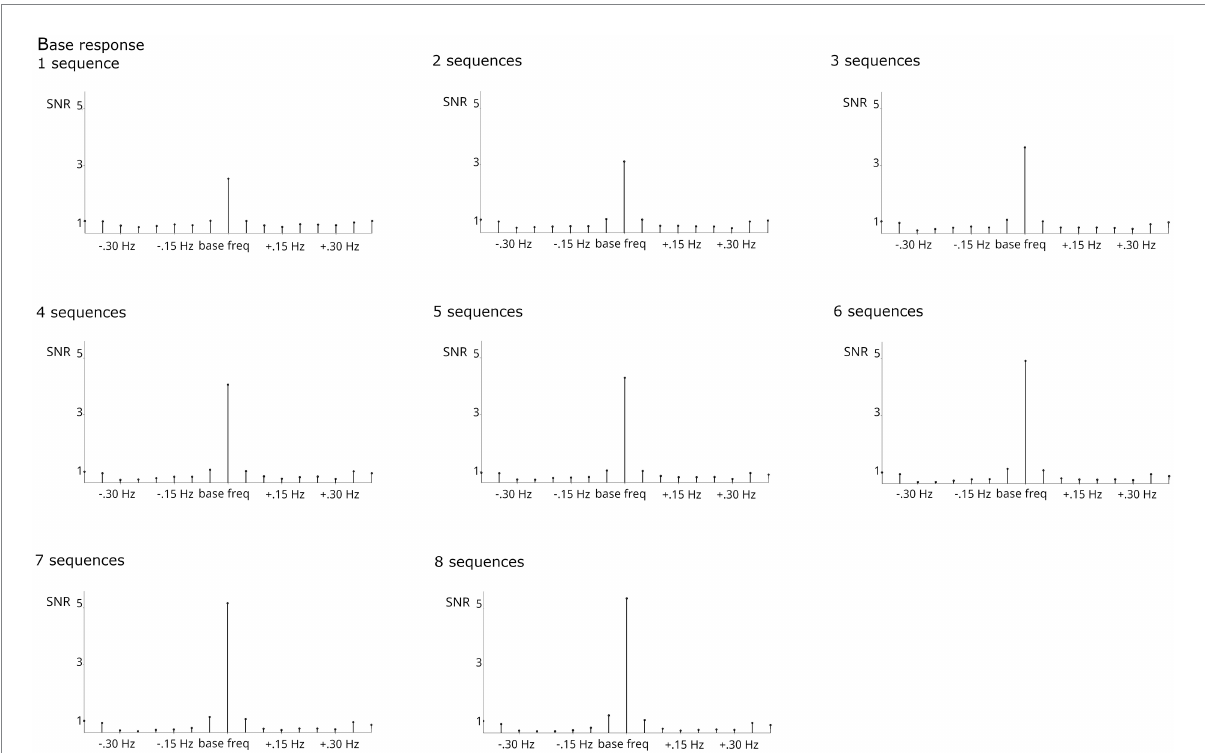
FIGURE 6 SNR of grand-average base responses summed across harmonics 1–5 and compared across numbers of sequences averaged for a subsample of N = 20 who provided usable data for at least 8 sequences. Highly significant base responses were obtained in all analyses, with a tendency for increasing amplitude with number of sequences averaged.